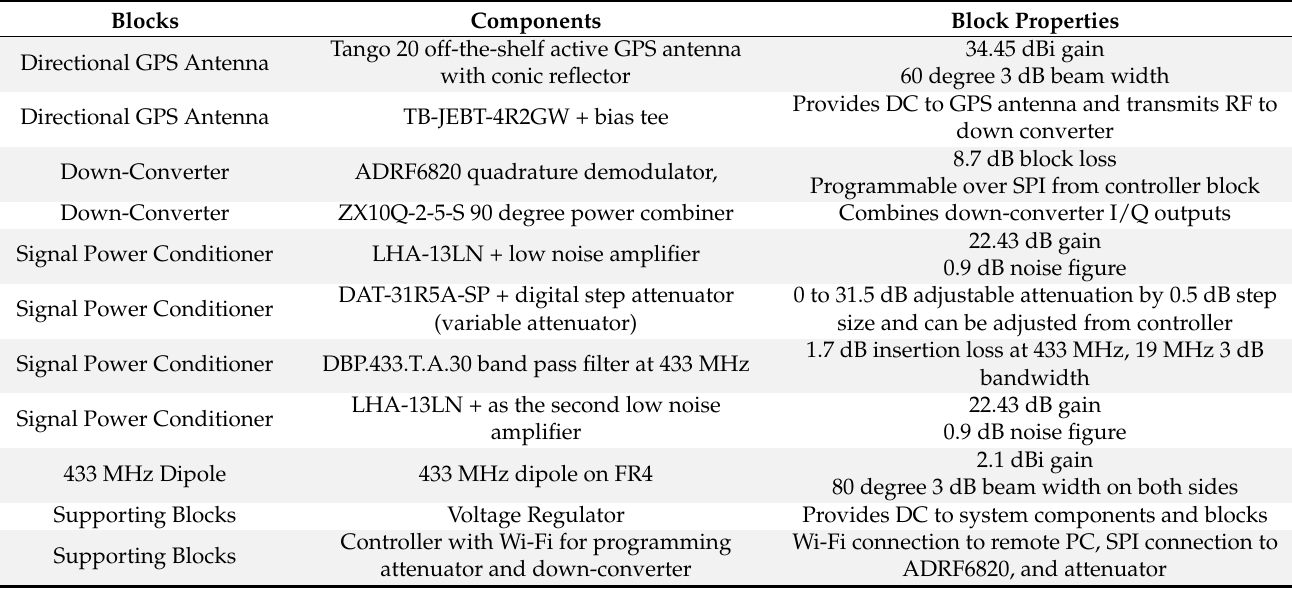
Table 1. Repeater subsystem and its components.